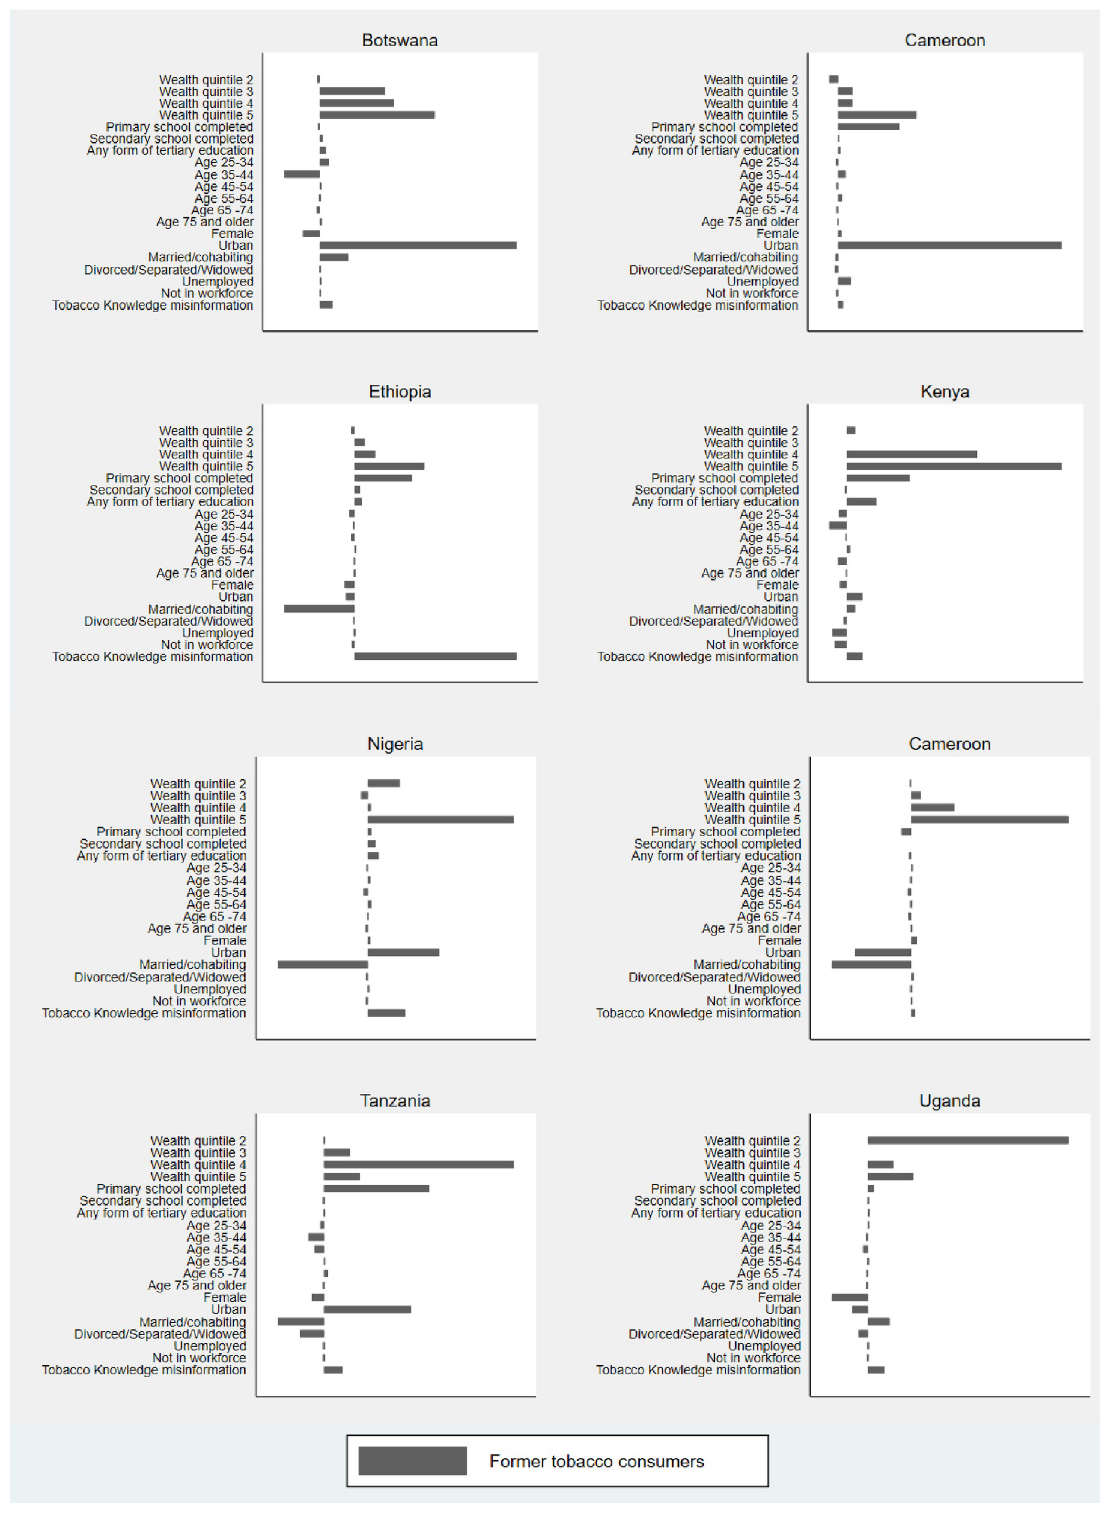
Fig 1. Percentage contribution of x in to wealth-related inequalities in TC F .